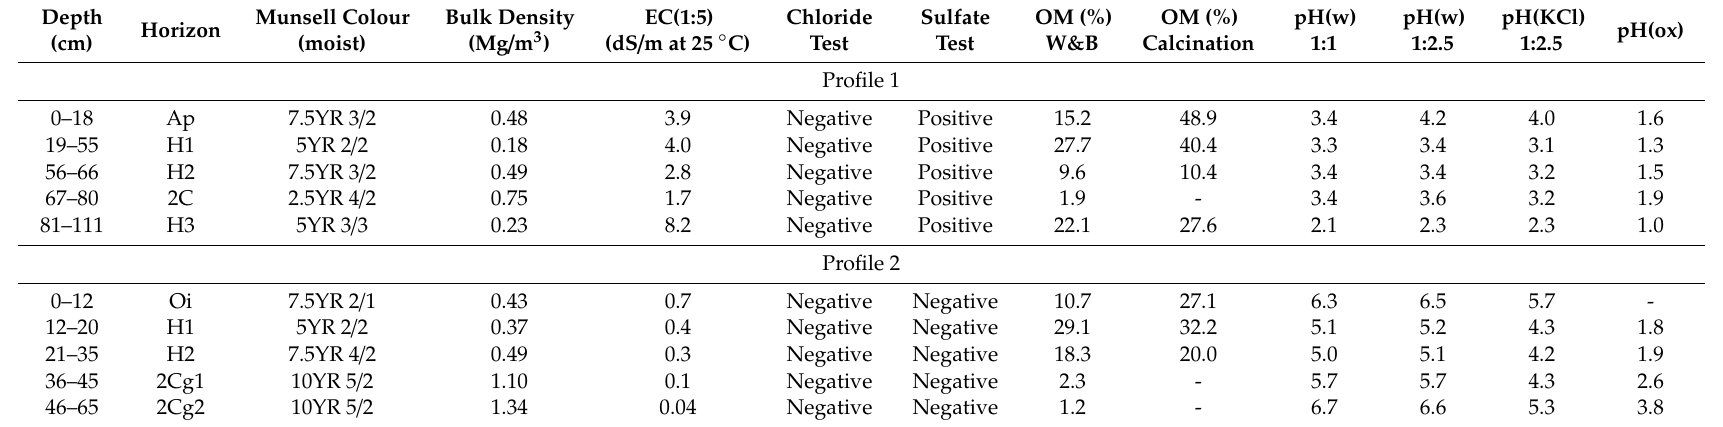
Table 1. Main physicochemical soil characteristics of profiles 1 and 2. EC: Electrical conductivity; OM: Organic matter; W&B: Walkley–Black